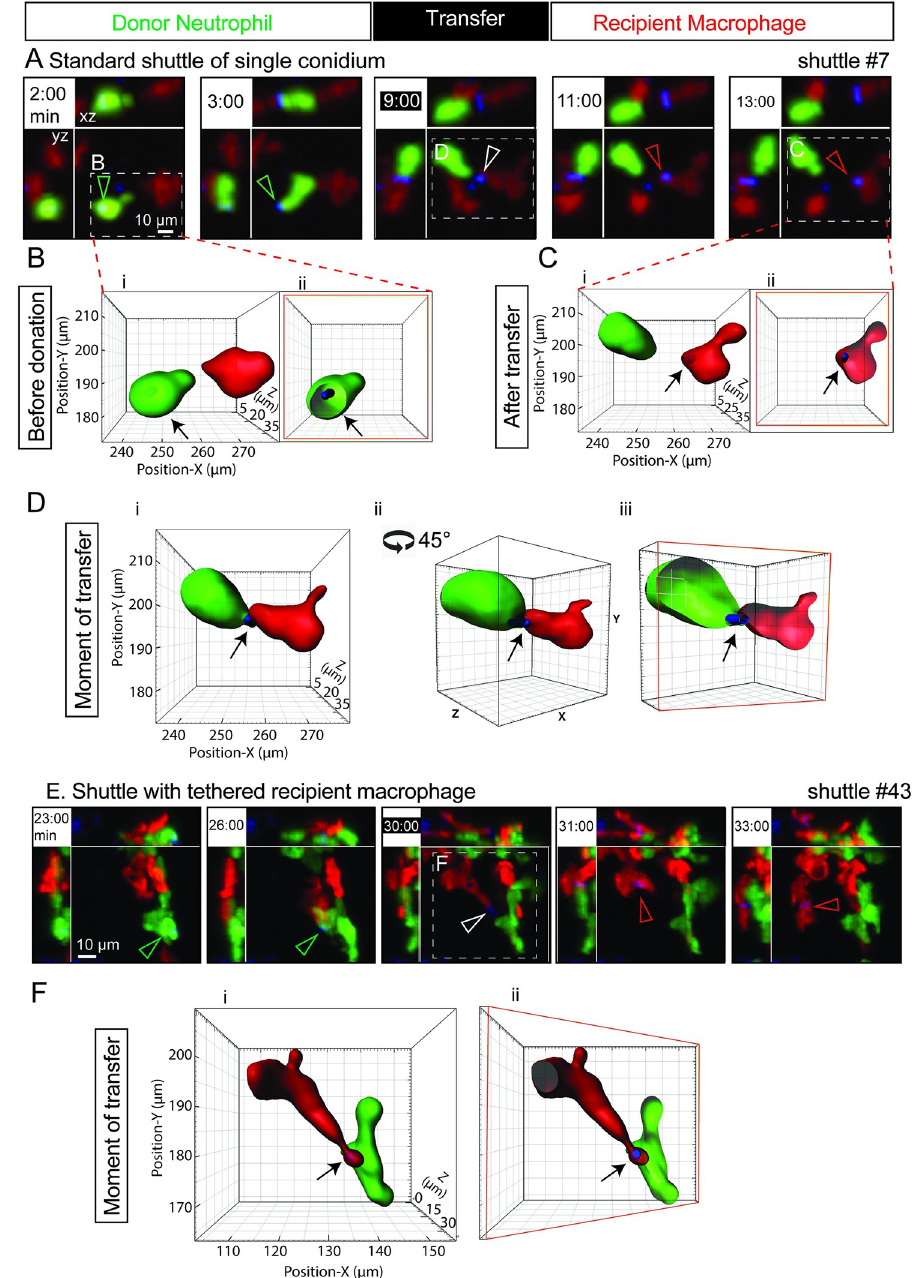
Fig 1. Shuttling of individual T . marneffei conidia from neutrophil to macrophage. (A) A representative standard shuttle of a calcofluor-stained conidium (blue) from a Tg(mpx : EGFP) neutrophil (green) to a Tg(mpeg1 : Gal4FF)×(UAS-E1b : Eco . NfsB-mCherry) macrophage (red), corresponding to the example in S1A Movie. Panels include isometric orthogonal yz and xz views corresponding to the xy maximal intensity projection and indicate the time in min from start of movie. The time point colored white-on-black is the moment of transfer. Colored arrowheads indicate the conidium within donor neutrophil (green), at the point of intercellular transfer (white) and in the recipient macrophage (red). (B–D) Volume-rendered views of the standard shuttle in (A), detailed before (B), at the moment of transfer (C), and afterwards (D), demonstrating the intracellular location of the shuttled spore in donor neutrophil and recipient macrophage, the focal intercellular contact at the moment of transfer. Cii is the image in Ci rotated 45˚ around a central vertical axis in the direction shown. Images Bii, Ciii, and Dii are sectioned volume- rendered views; a sectioned plane is represented by a red box. (E–F) Shuttle demonstrating tethering of the departing recipient macrophage following a shuttle. Panel E presentation organized as in panel A. The tethered moment